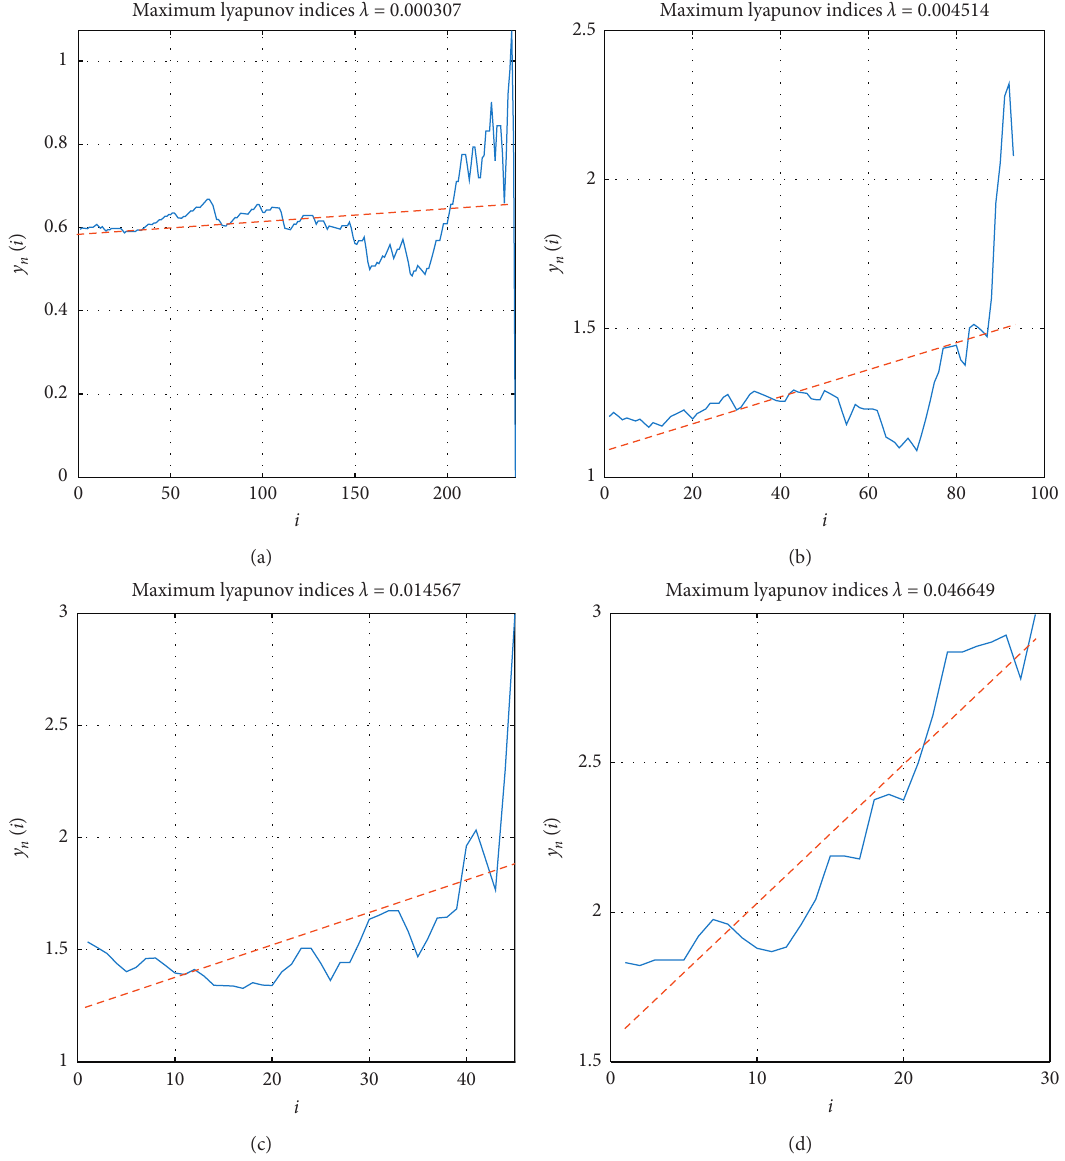
Figure 8: Analysis chart of the largest Lyapunov index of the sample. (a) Δ t � 2min. (b) Δ t � 5min. (c) Δ t � 10min. (d) Δ t �